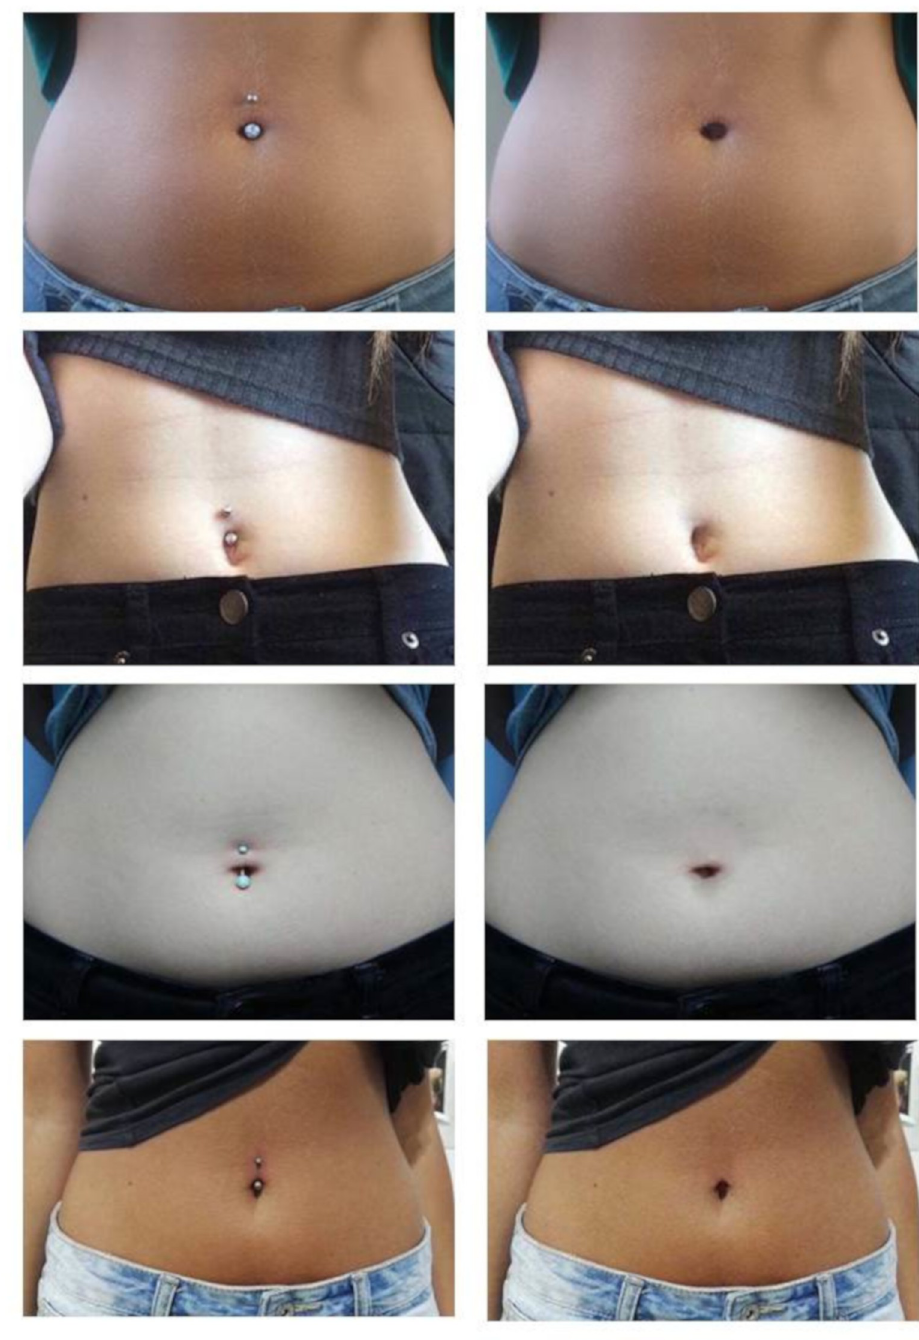
Fig 2. Examples of images depicting women’s abdomens with (left panel) and without (right panel) navel piercings.